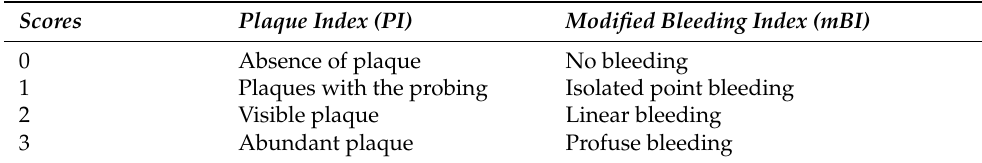
Table 1. Peri-implant indices considered in the